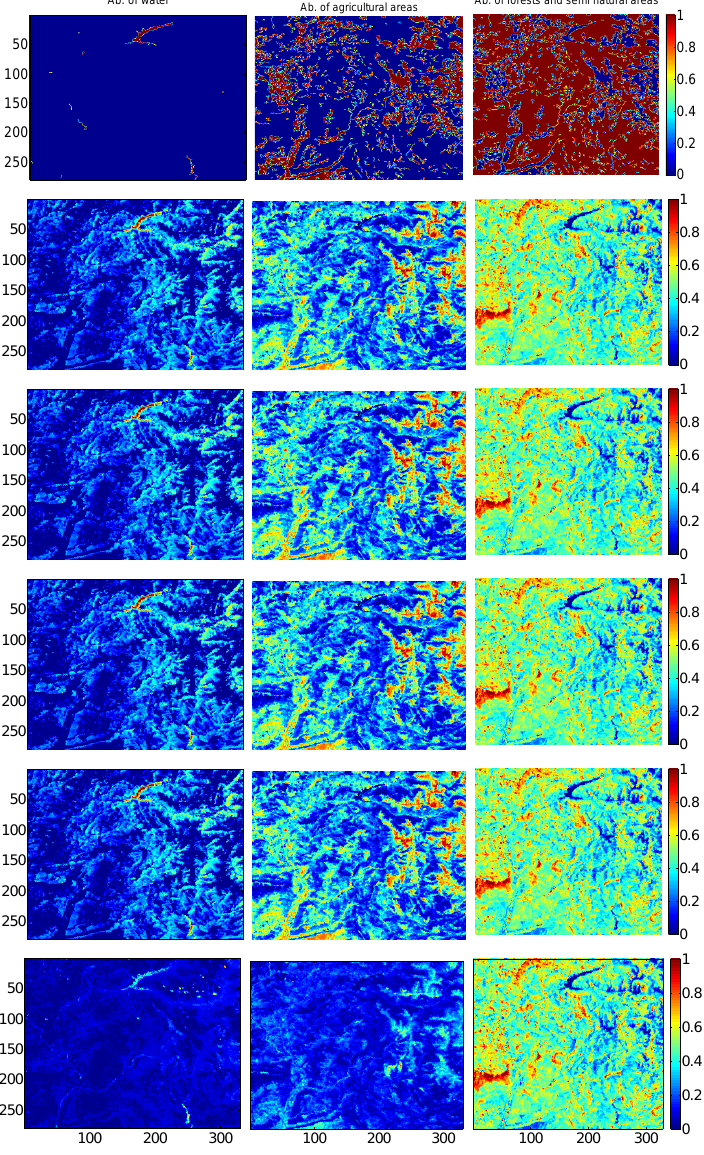
Figure 7. Abundance maps estimated by the proposed NU-BGBM and the compared methods for the gulf of Lion real HSI. From top to bottom: estimated visual ground truth, FCLS, GDA, semi-NMF, BPOGM, and